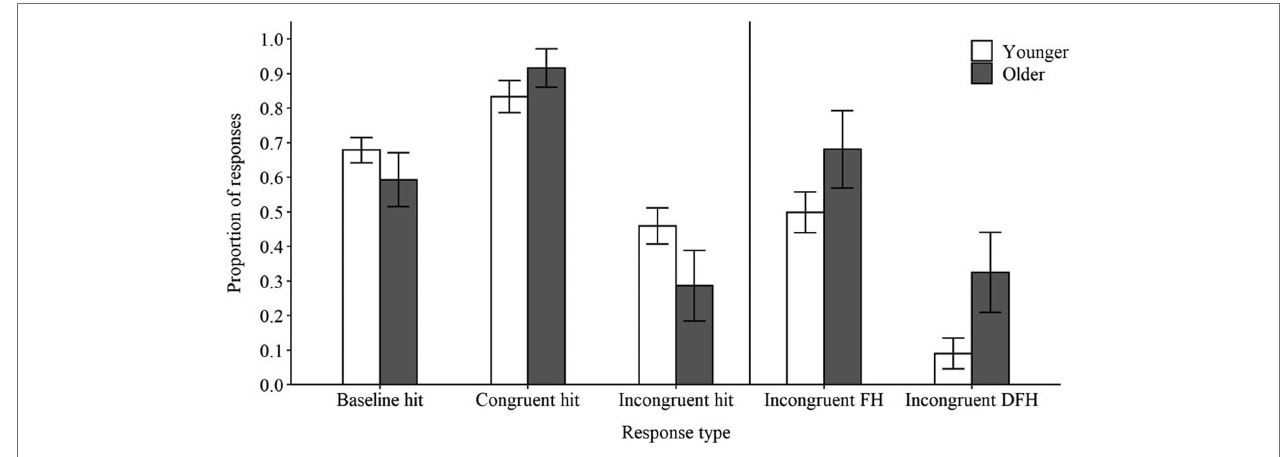
FIGURE 2 | Average proportion of hits (left side) and susceptibility to false hearing (FH; right side) and dramatic false hearing (DFH) for younger and older adults. Error bars represent 95% confidence